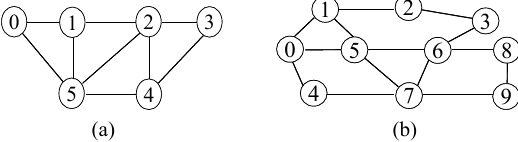
Fig. 6 Network topologies used in the static case (a) 6-node network topology (b)10-node network topology.